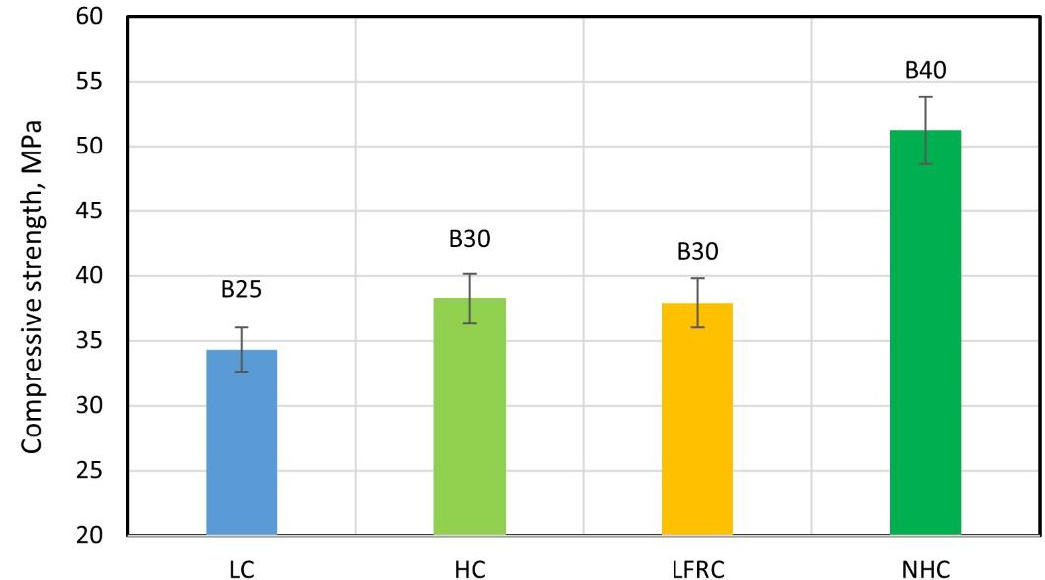
Figure 7. Compressive strength of the studied types of concrete.